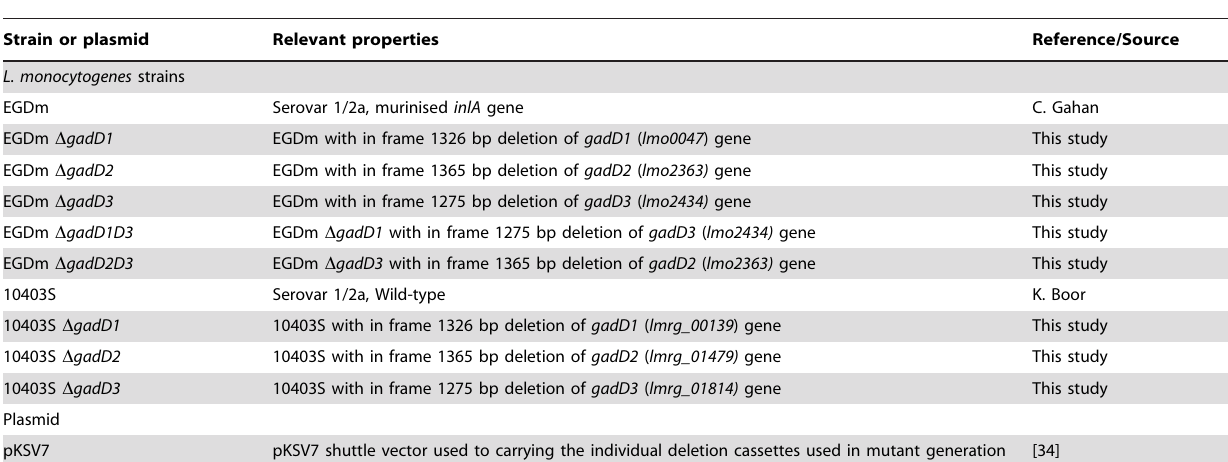
Table 1. Bacterial strains and plasmids used in this